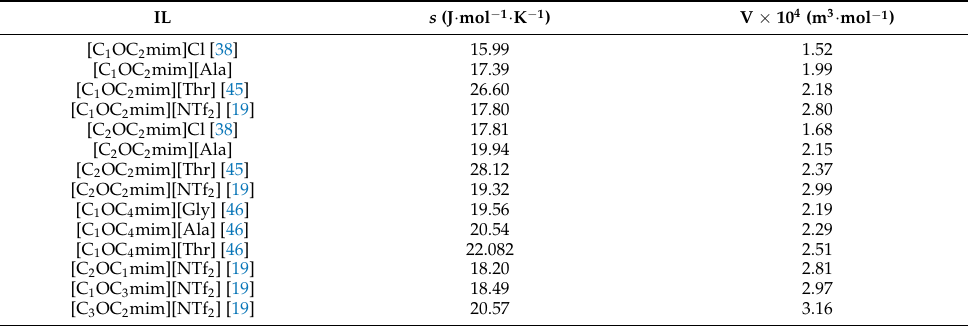
Table 4. Molar surface entropy ( s ) of various